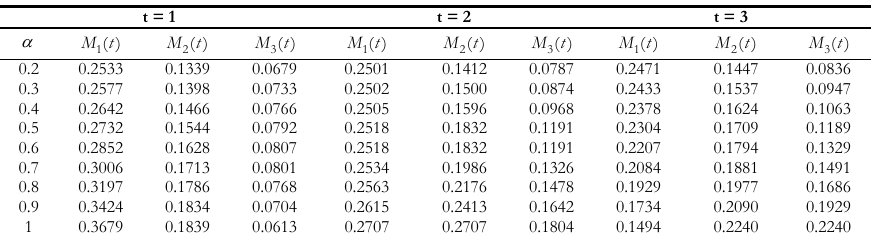
Table showing values of Mittag-Leffler count model probabilities for different values of the parameter  at t = 1,2,3